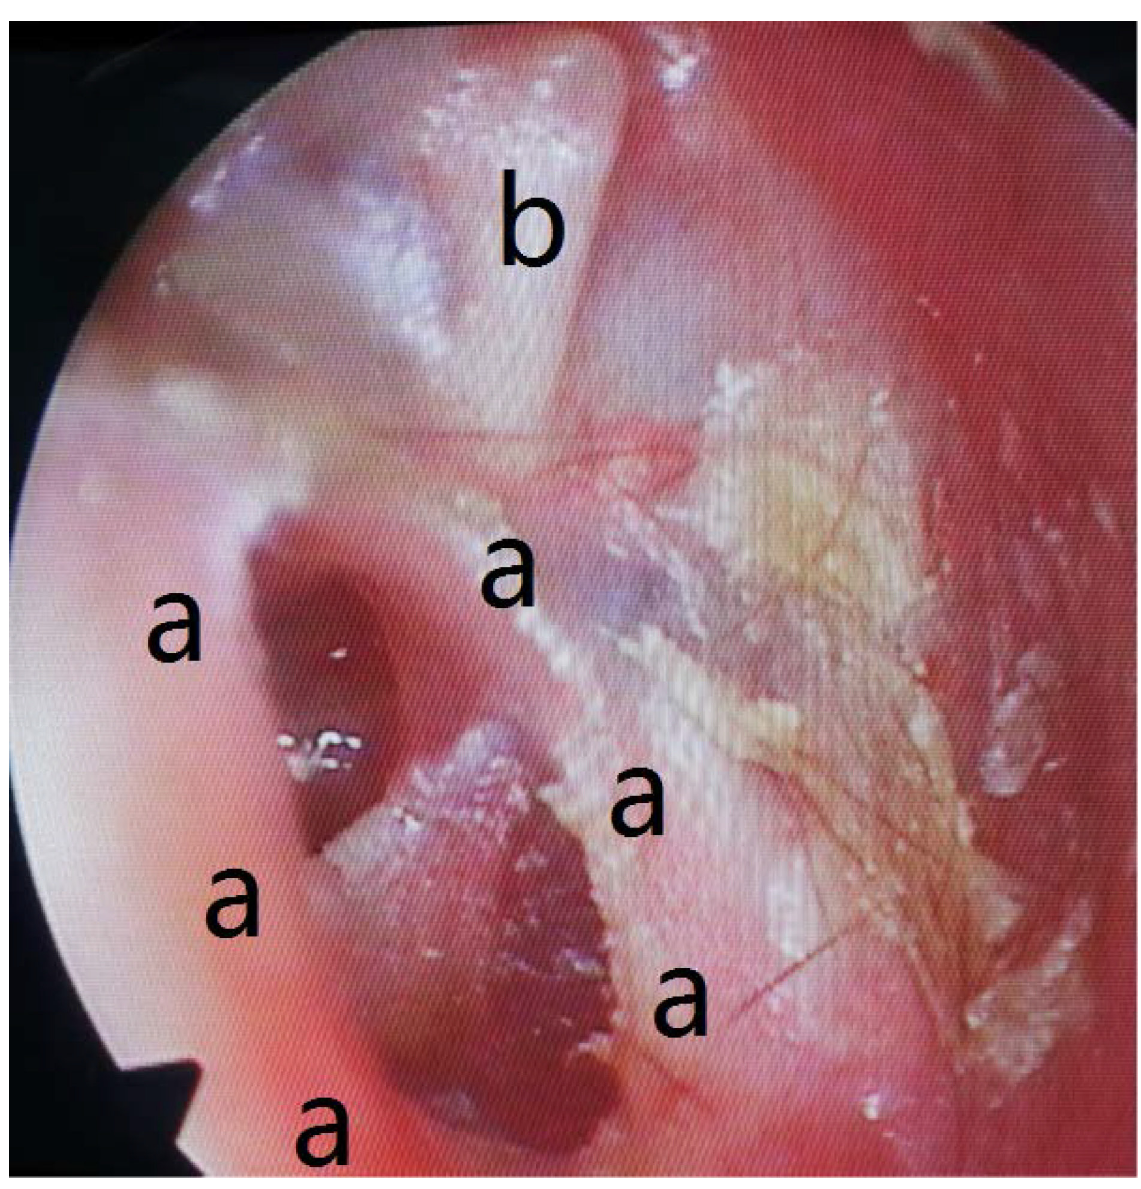
Fig 2. Preoperative transcanal endoscopic view: (a) Malleus; (b) Tympanic membrane perforation (evident after the cholesteatoma